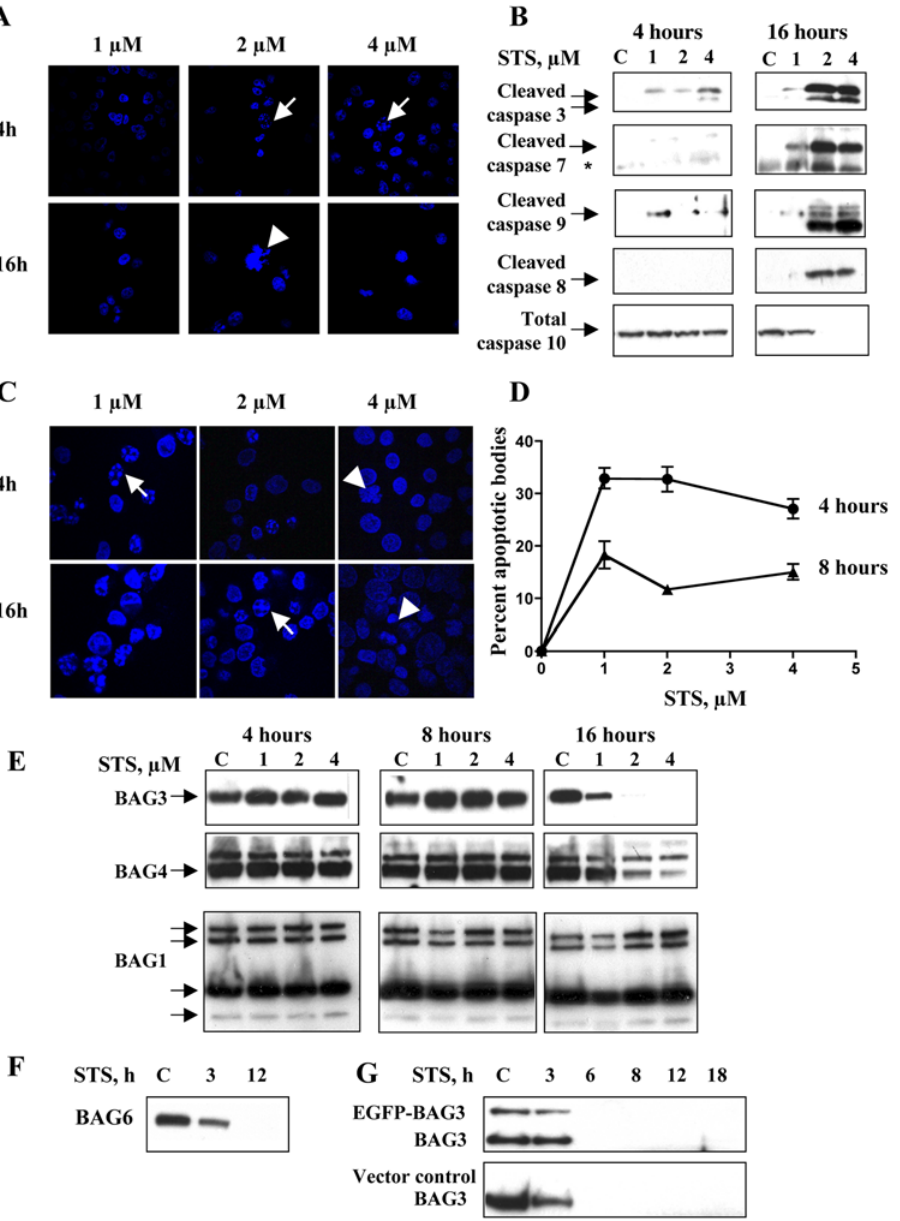
Figure 1. STS induced apoptosis and degradation of BAG3. A. STS induces cellular injury in a dose and time-dependent fashion. DAPI-stained STS-treated MDA435 cells show chromatin condensation consistent with apoptotic injury. Apoptotic bodies were observed with 2 and 4 m M STS at 4 hr (arrows) and there was a net loss of cells at 16 hrs. B. STS-mediated degradation of BAG3 occurs concomitant to activation of caspases 3, 7 and 9. Cleavage of caspases 3 and 9 were observed as early as 4 hrs into STS treatment. In comparison activation of caspases 8 and 10 was delayed, occurring after BAG protein loss was initiated. C, D. STS induces apoptosis in HeLa cells. Apoptotic bodies were observed in DAPI stained cells. Data points are the mean and SEM of five independent fields (n=2). E, F. BAGs 3, 4, and 6 are lost progressively with STS treatment. Floating and adherent MDA435 cells were collected, lysed, and subjected to immunoblot. BAGs 3 and 4 (E), and 6 (F) were lost with STS exposures of 3–16 hrs. No reduction in the p50, p46, p34, or p29 BAG1 isoforms was observed (E). G. STS-mediated BAG3 degradation is neither cell line nor construct-specific. EGFP-BAG3 or EGFP-C1 empty vector were stably expressed in HeLa cells. Cells were exposed to 2 m M STS and both endogenous BAG3 and EGFP-BAG3 fusion proteins were lost over time, as early as 6